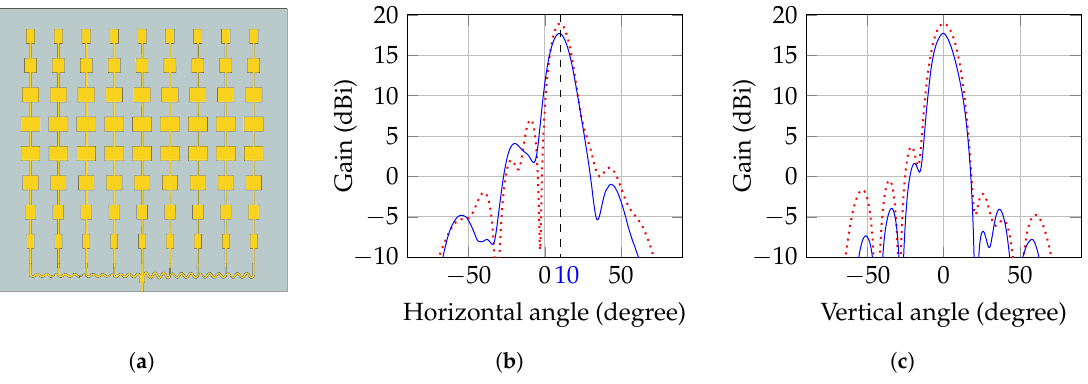
Figure 5. Antenna layout and radiation patterns of the series-fed patch array. ( a ) Antenna layout used for the field simulations; ( b ) Simulated (dashed) and measured (solid) radiation pattern in horizontal plane; ( c ) Simulated (dashed) and measured (solid) radiation pattern in vertical plane at 10 ◦